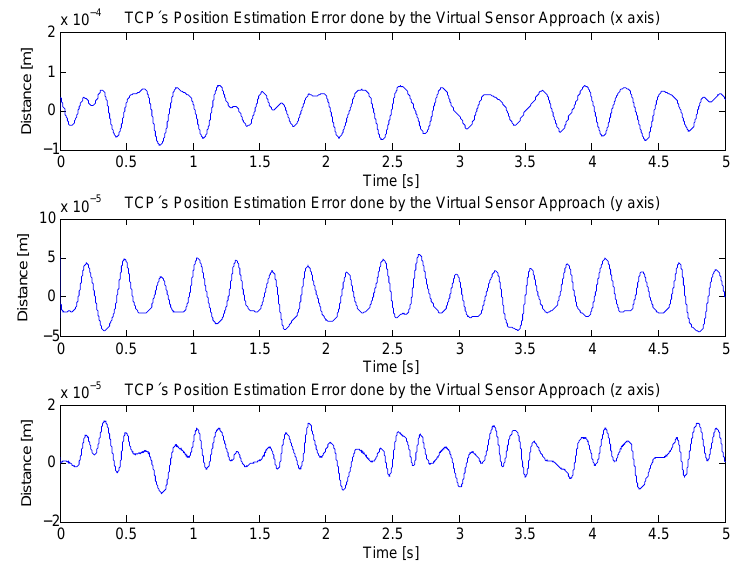
Figure 13. Virtual Sensor TCP deflection estimation error compared with the TCP’s deflection obtained with ADAMS Multibody